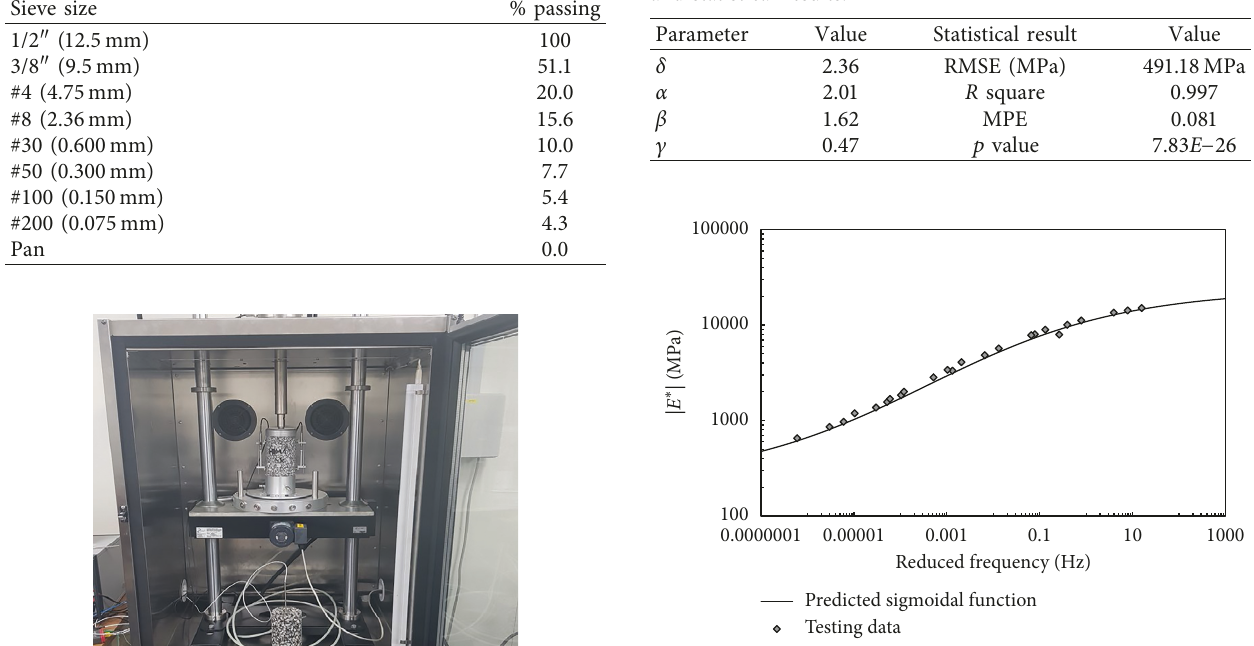
Table 2: Parameters of the sigmoidal function, e.g., Equation (15)) and statistical results.